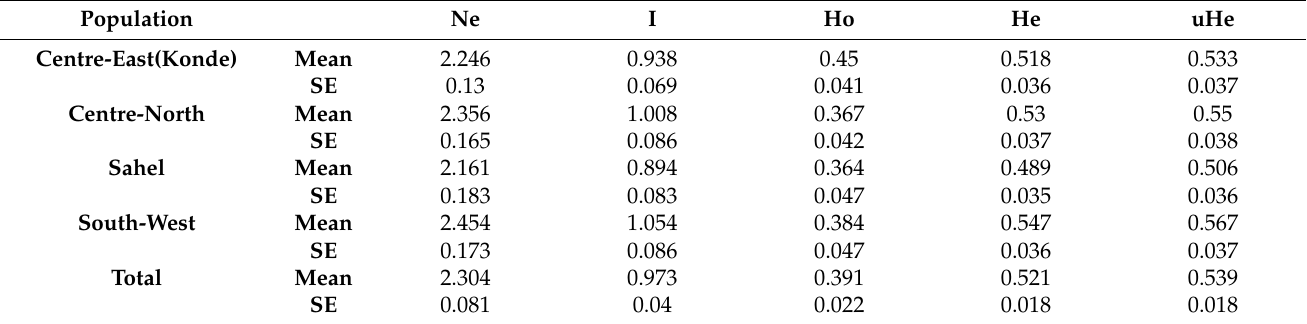
Table 2. Effective number of alleles (Ne), Shannon index (I), observed (Ho), expected (He) and unbiased (uHe) heterozygosity, by